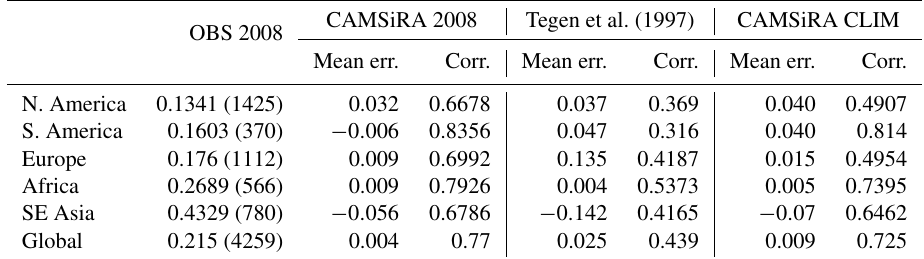
Table 2. Comparison between model and observation AOT for the year 2008 at AERONET sites. Model values are from the prognostic AOT from the CAMS Interim reanalysis (CAMSiRA 2008) and two climatological fields from TG97 and from the current work (CAMSiRA CLIM). The columns report the mean error and the correlation coefficient for five macro areas and globally for all sites. The size of the sample used to compute these statistics is reported in brackets in the observations (OBS) column.